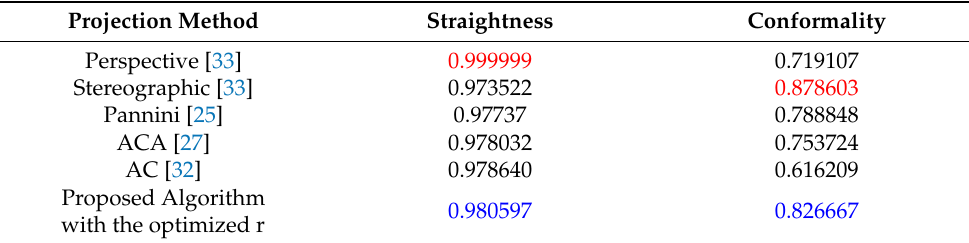
Table 2. Quantitative evaluation of the projection results.